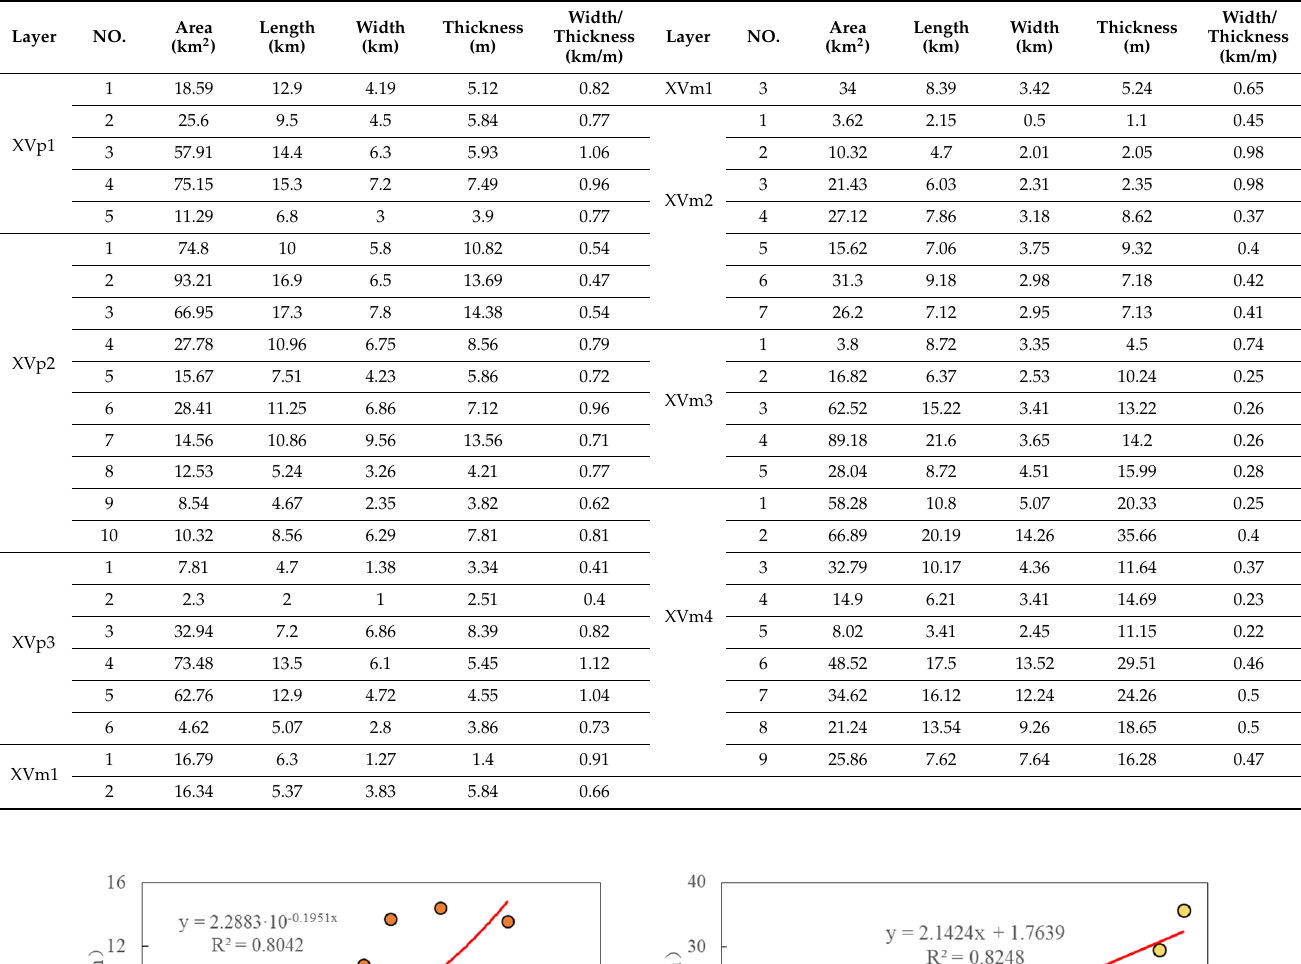
Table 1. Statistical table of reef and shoal in layer.